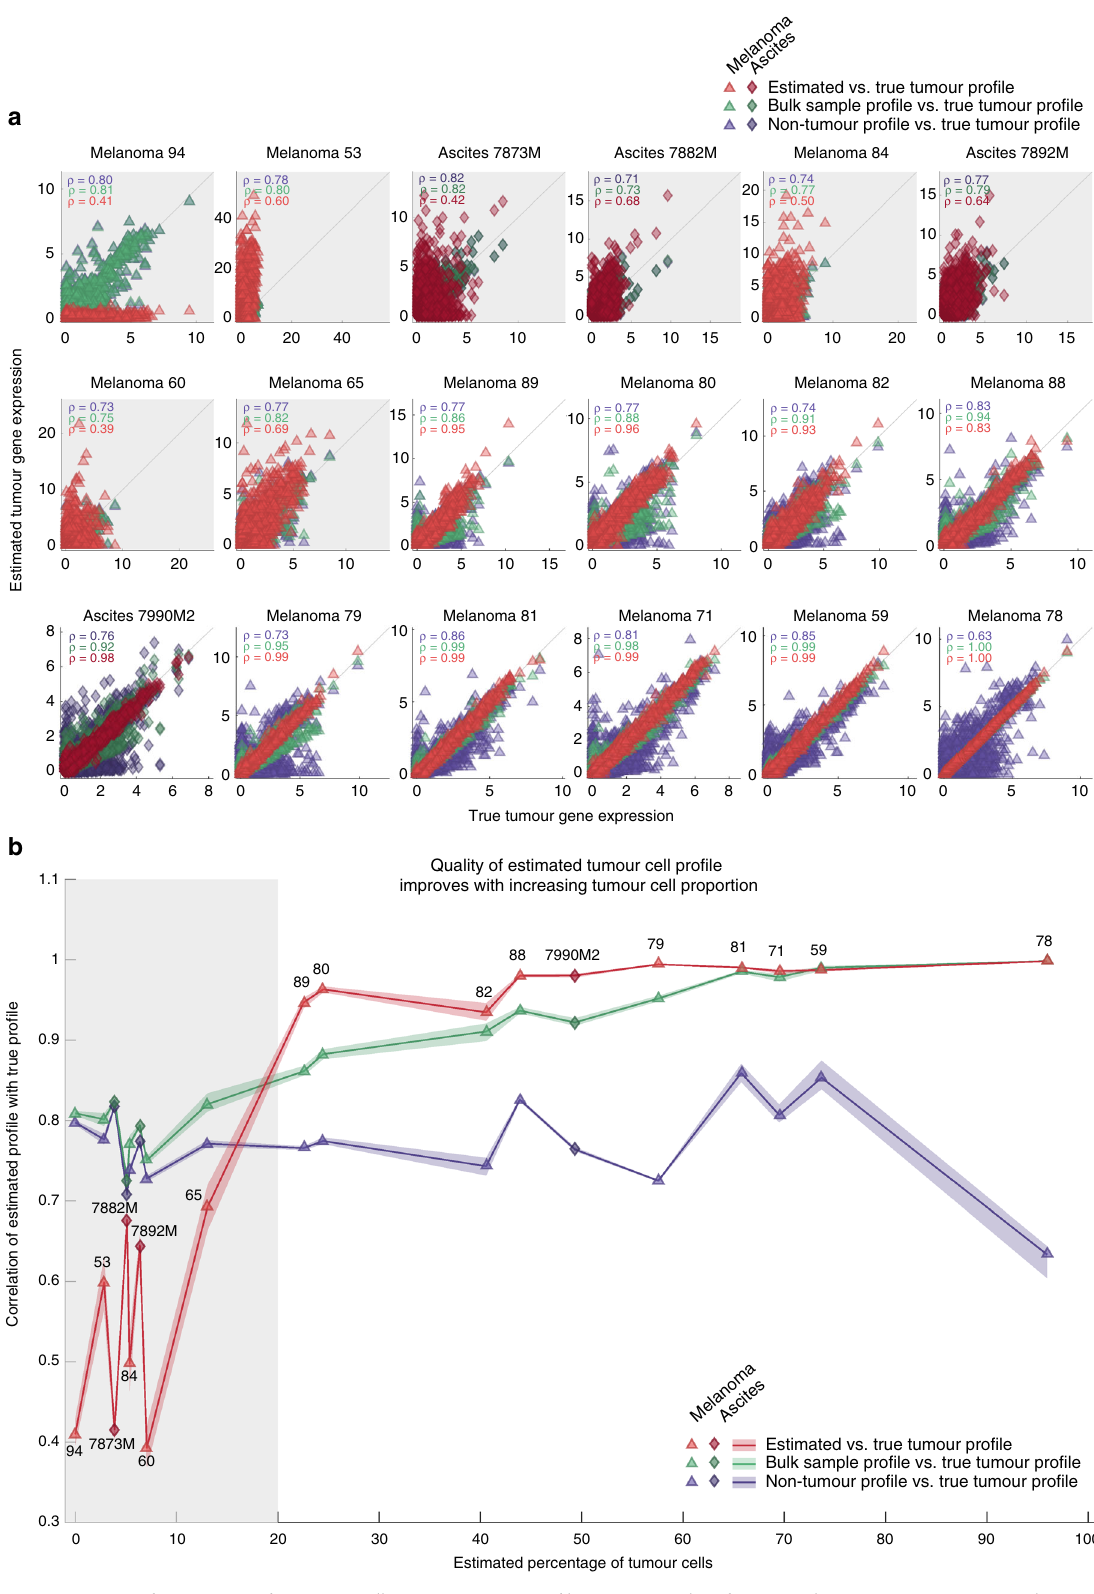
Fig. 7 Estimation accuracy of patient-speci fi c tumour cell gene expression pro fi les. a Scatter plot of estimated vs. true transcriptome wide gene expression (17,933 genes) of the tumour cells for individual patient samples. Patient samples without any tumour cells have been excluded from this analysis. ρ denotes the Pearson ’ s correlation. Correlation plots with grey background indicate patient samples with less than 20% tumour cell content. Colours according to legend in panel b . b Correlation values from panel a plotted against the estimated proportion of tumour cells for each patient sample. Shading represents uncertainty based on bootstrapping. Symbols and numbering denote individual patient samples